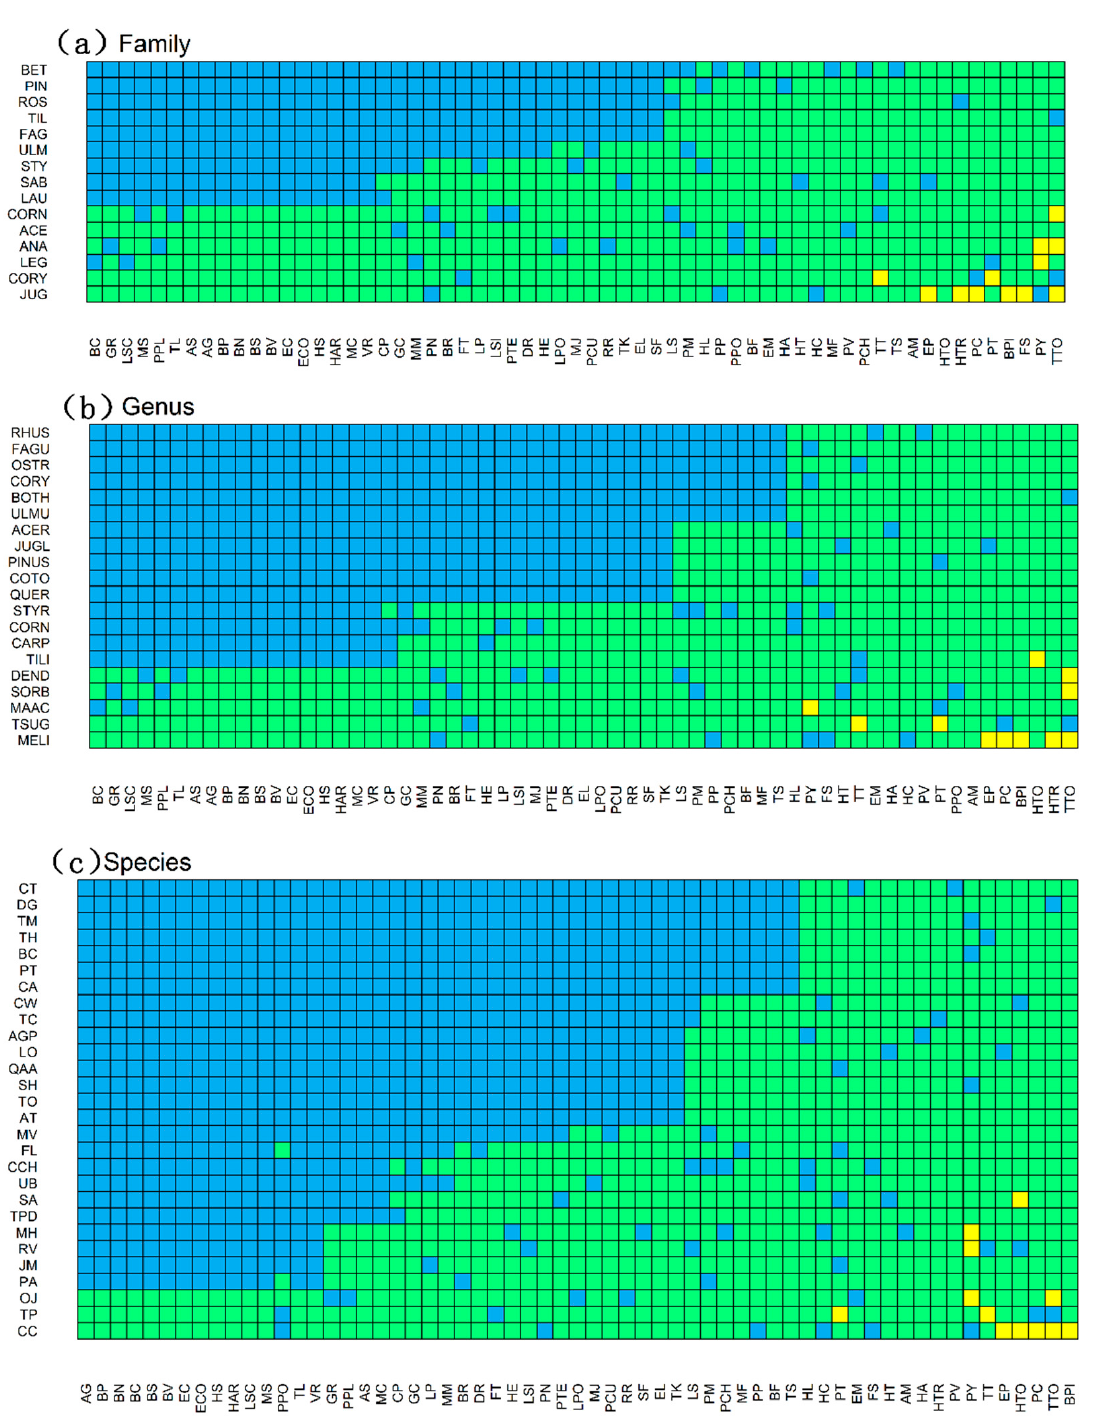
Figure 4. Associations between bryophyte species and woody plants ( α = 0.05 level of significance for torus-translation test). Blue squares denote significant positive associations, yellow squares denote significant negative associations, and green squares denote neutral associations. The abbreviations of woody plant and bryophyte species are shown in Tables S4 and S5. ( a ) is at family level, ( b ) is at genus level and ( c ) is at species level.